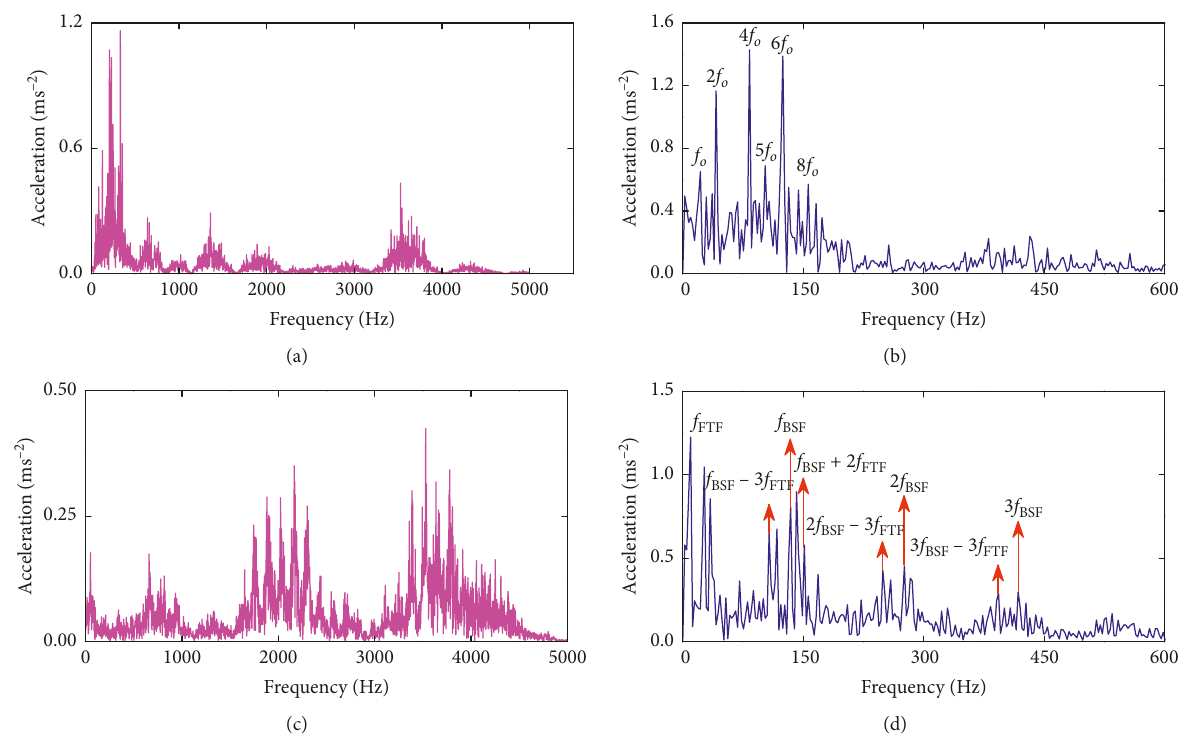
Figure 37: Fourier and envelope spectra: (a) Fourier spectra of IRS1; (b) envelope spectra of IRS1; (c) Fourier spectra of IRS2; (d) envelope spectra of